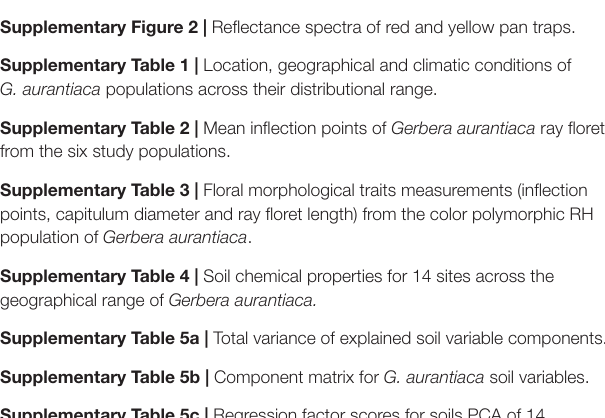
Supplementary Figure 1 | Scree plot showing eigenvalues of principal components for edaphic variables of 14 G. aurantiaca population. Supplementary Figure 2 | Reflectance spectra of red and yellow pan traps.